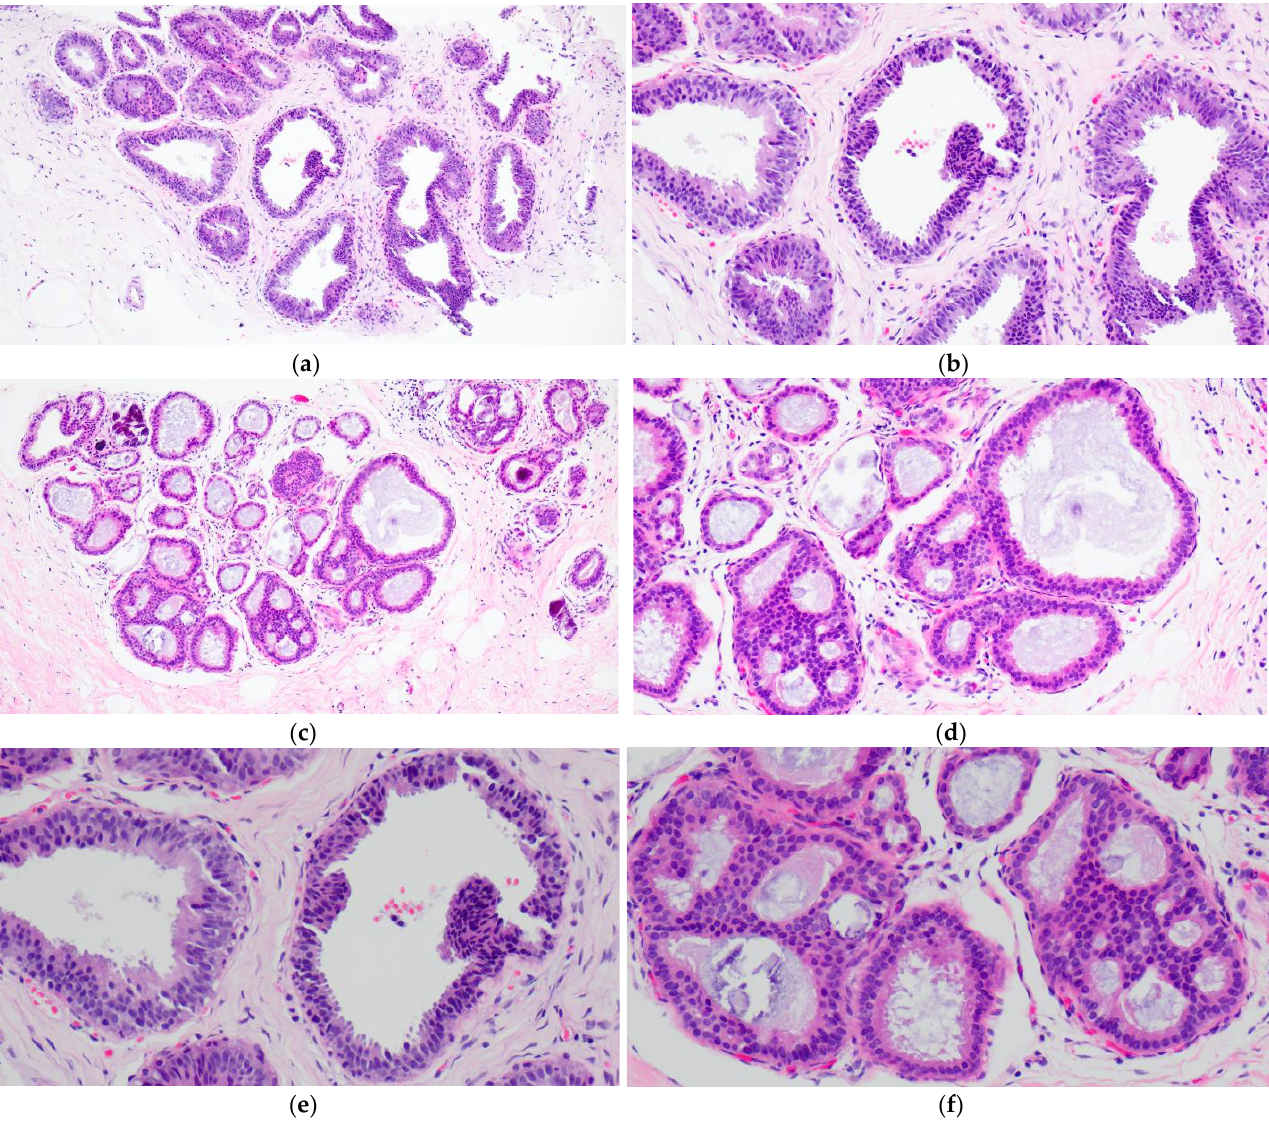
Figure 4. Columnar cell lesion (CCL) with foci of architectural complexity comprising focal formation of a micropapillary structure ( a , b , e ) and cribriforming with rigid cellular bridges ( c , d , f ) associated with low-grade cytologic atypia, consistent with atypical ductal hyperplasia.